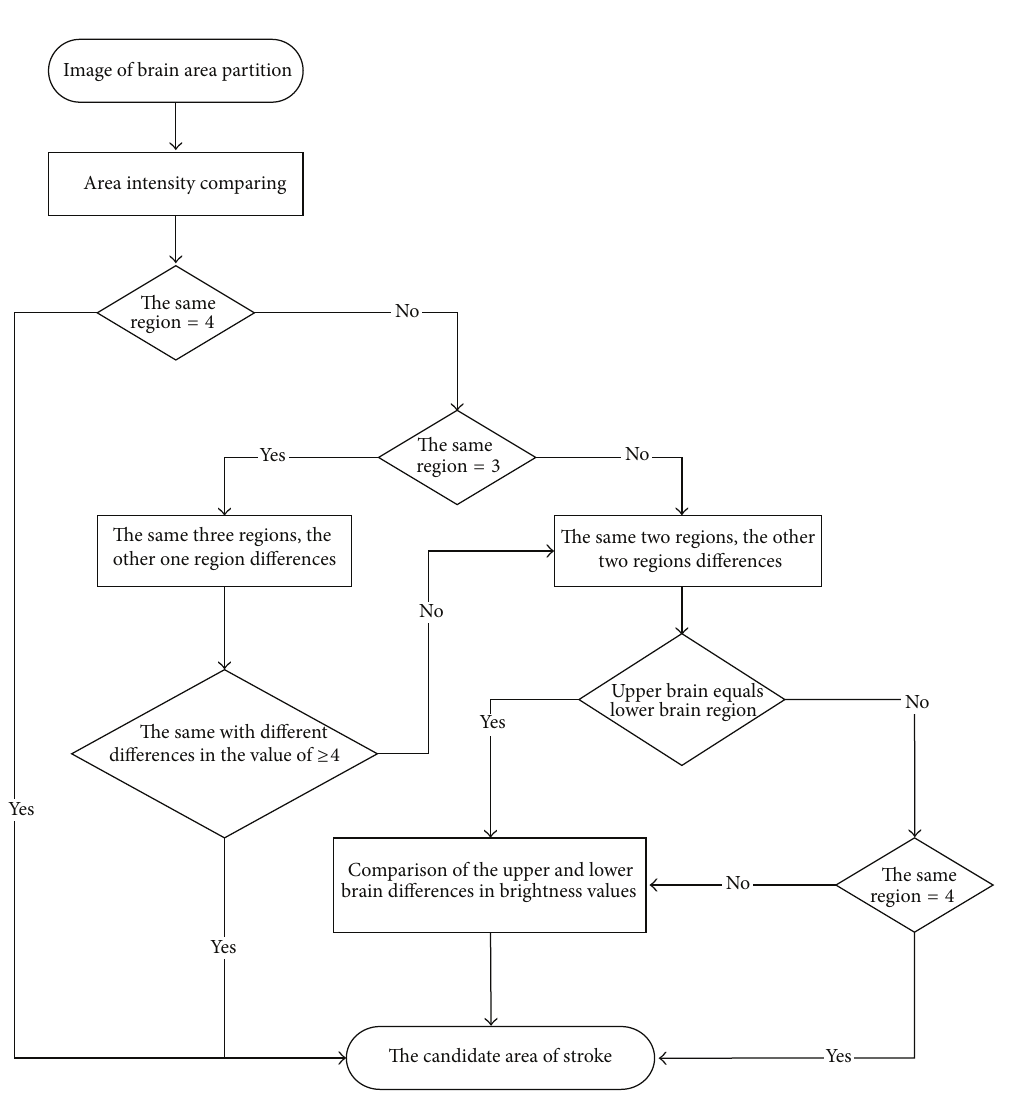
Figure 8: The flowchart of coinciding regional